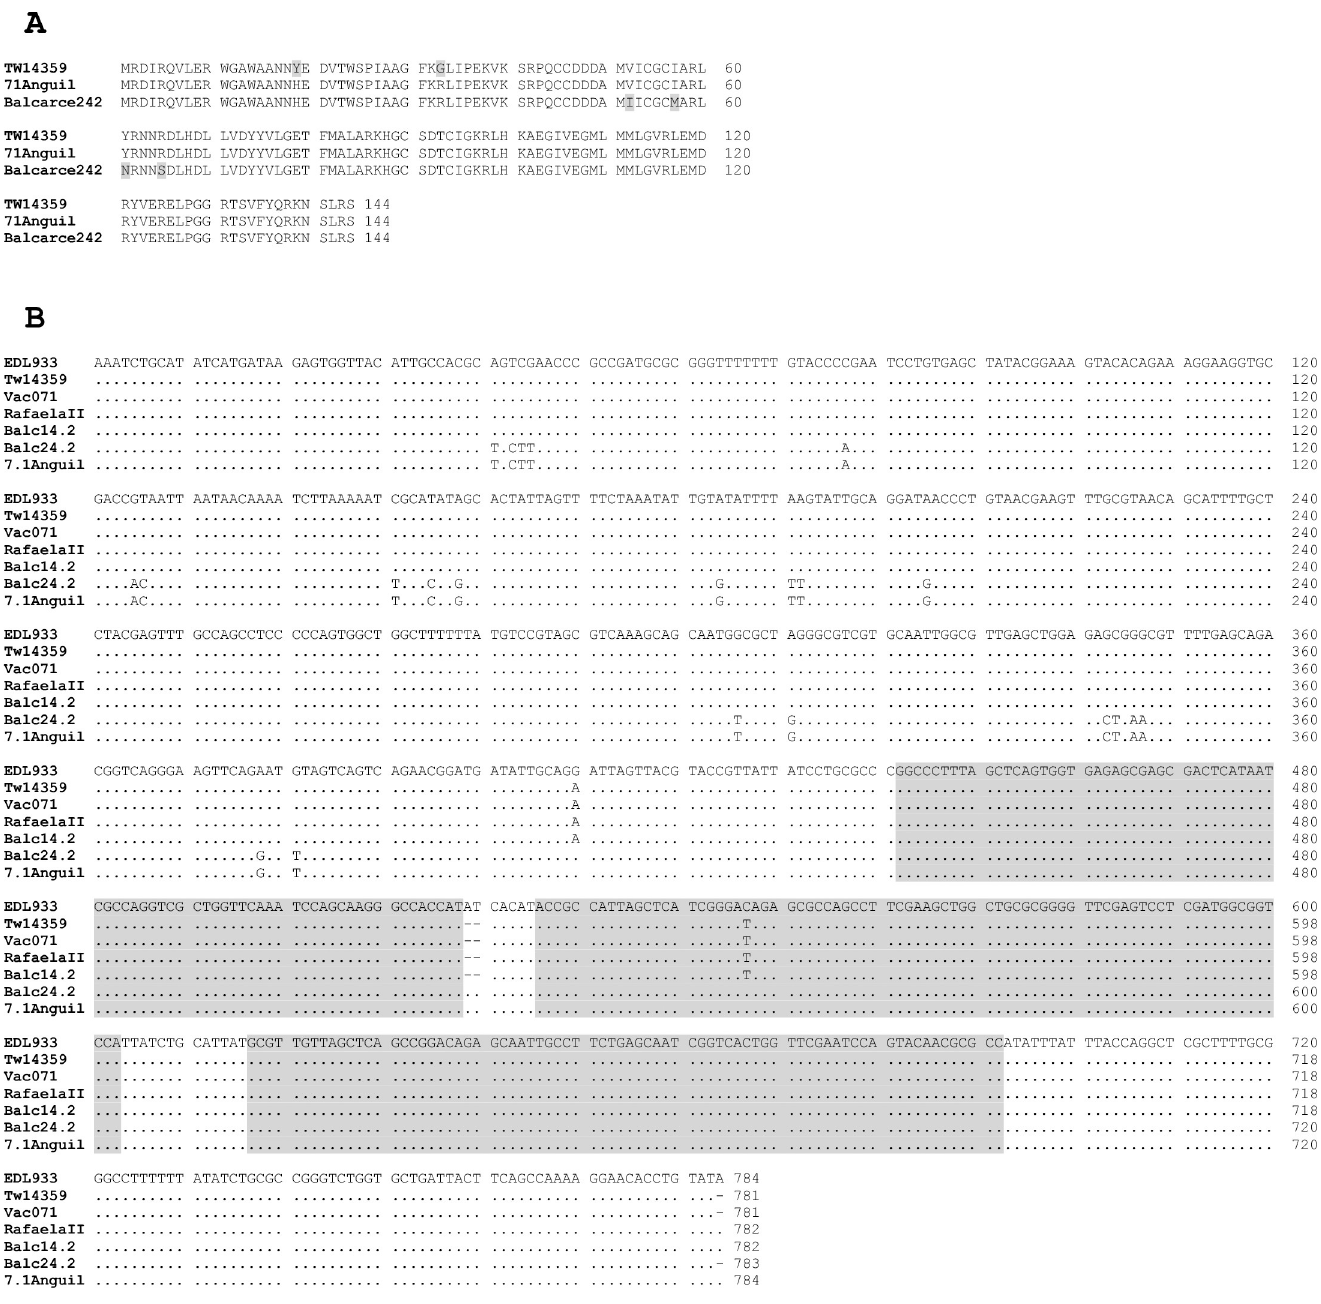
Fig 6. (A). amino acid substitutions (shaded in grey) in the Q antiterminator gene, (B) SNPs in Q-stx2A intergenic region. EDL933 sequence is used as reference. Dots represent nucleotide that are identical to the reference. SNPs are represented by the substituting nucleotide. A tRNA present in the intergenic region is shaded in